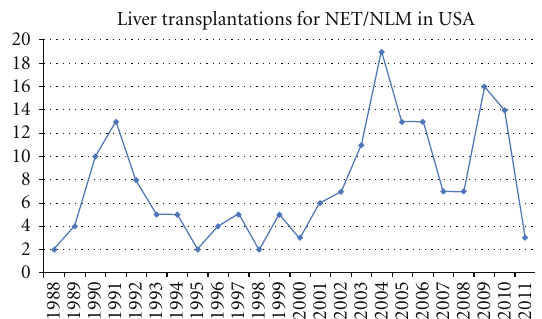
Figure 1: Liver transplantations for NET/NLM in USA. Note the significant increase in average number of transplantation which occurred after the introduction of the MELD/PELD score in 2002.